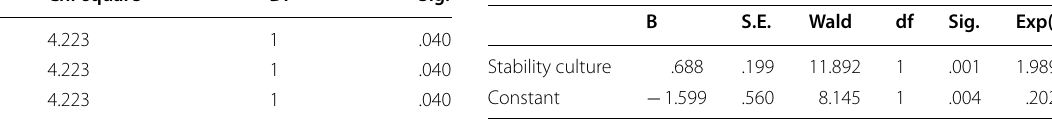
Table T: Variables in the equation for stability